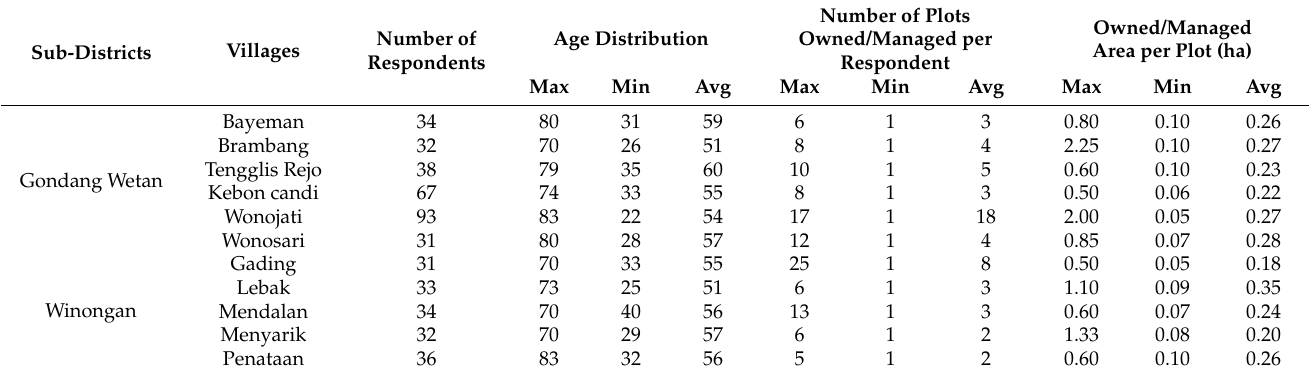
Table 2. Respondent distribution and characteristic of paddy cultivation